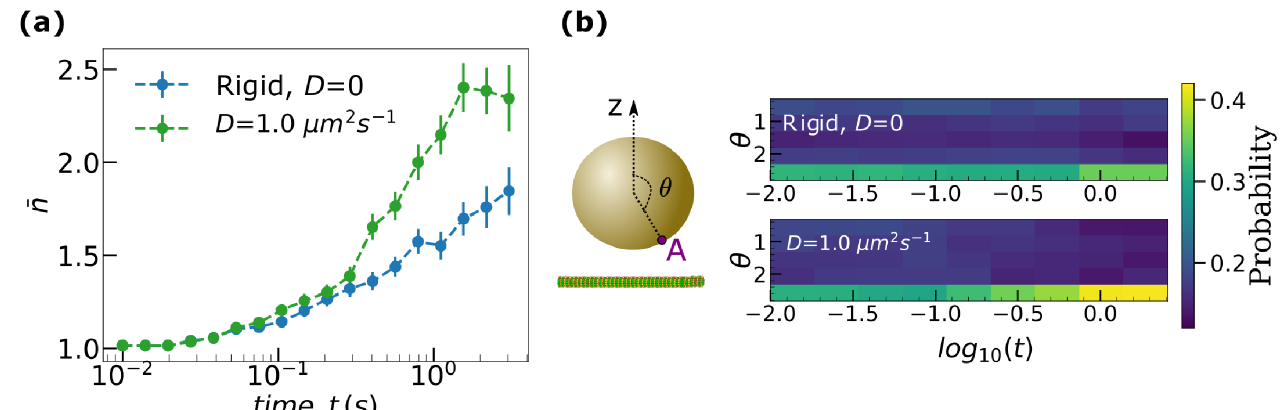
Fig 4. Surface fluidity increases the availability of motors for binding. (a) Ensemble average of the number of bound motors, � n as a function of time (s). Error bars represent the standard error of the mean. (b) Spatial distribution of the kinesin motors on cargo, computed as the probability of locating motors as a function of the polar angle θ and time, t . θ is the polar angle of the motor, measured with respect to z axis perpendicular to the microtubule and passing through the center of the cargo. Data was obtained from the transport of cargoes with a total of N = 16 motors at [ATP] = 2